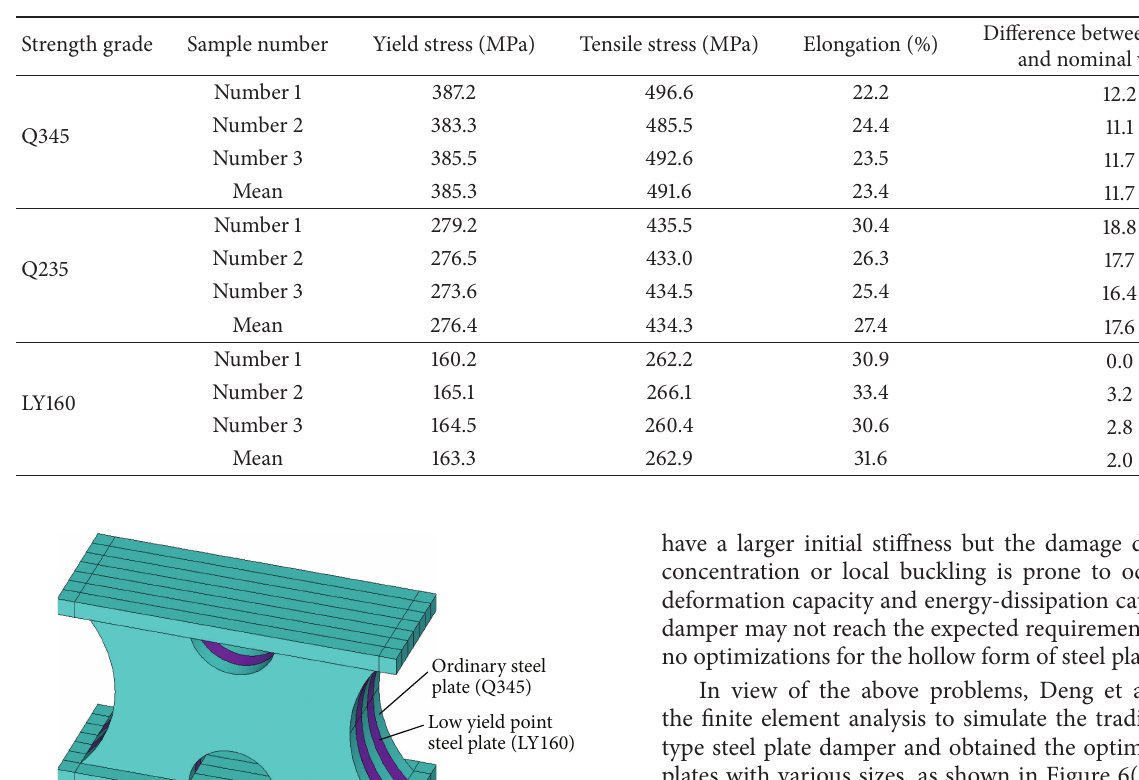
Table 1: Results of monotonic tensile test.